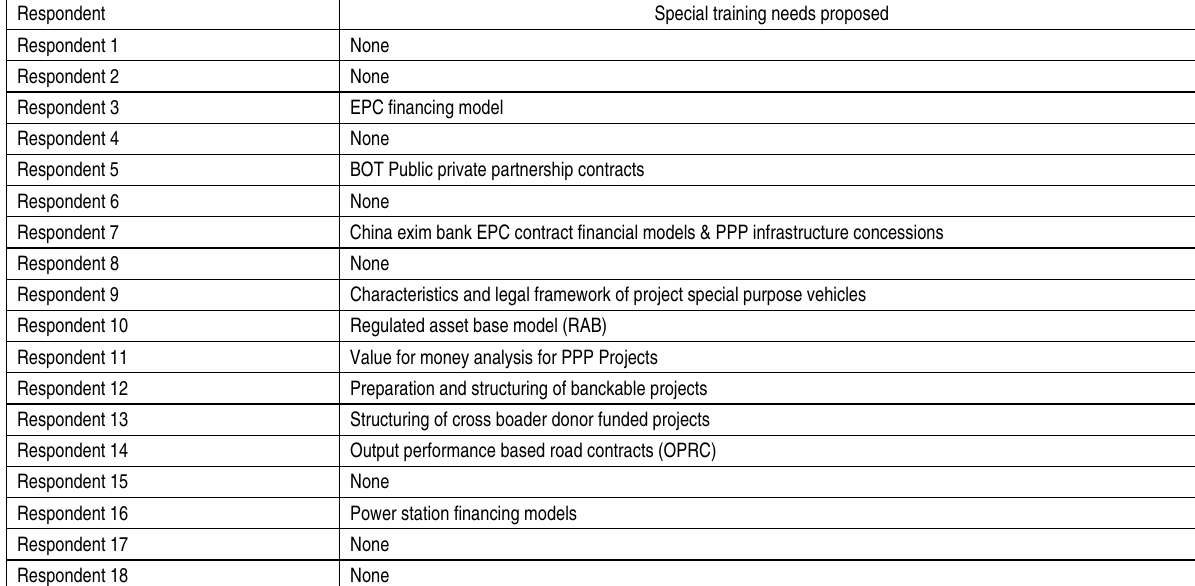
Table 4. Proposal per official of special finance training